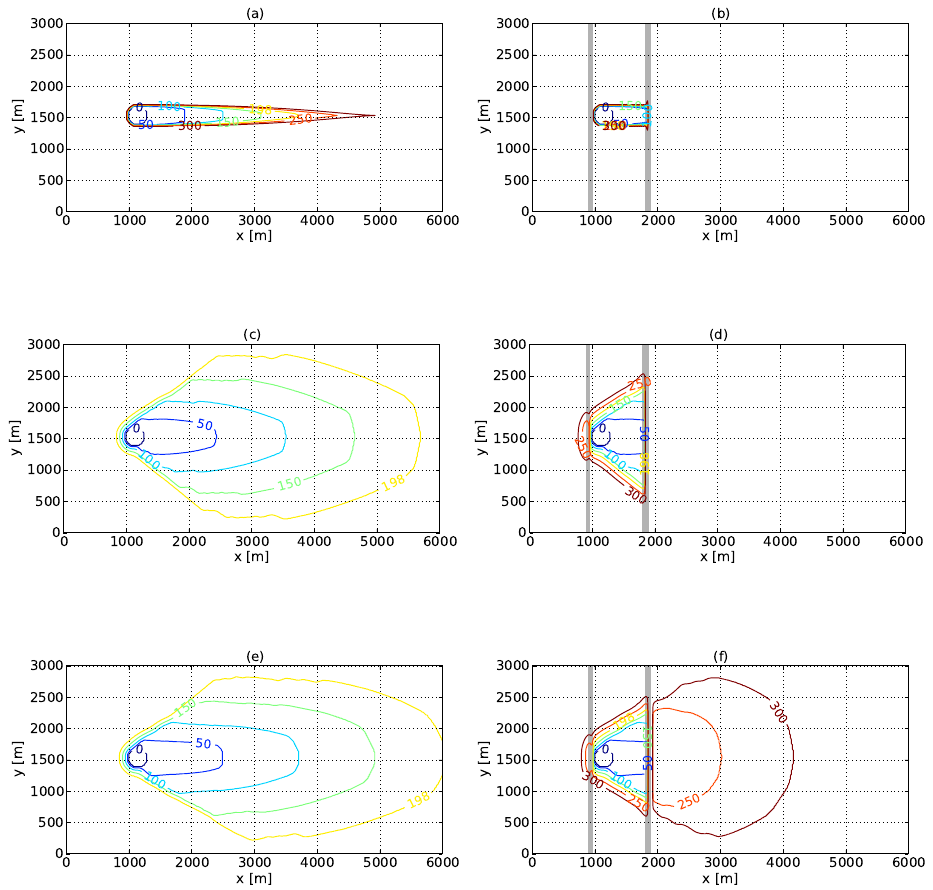
Figure 3. The same as in Fig. 1, but when the mean wind velocity and the fire intensity are U t =17.88ms − 1 and I =10000kWm − 1 (case C ). Fig. 3. The same as in Fig. 1 but when the mean wind velocity and the fire intensity are U t = 17 . 88ms − 1 and I = 10000 kW m − 1 (case C ). (without and with fire breaks), the results obtained by adopt- Figs. 1, 2, 3 and 4, show that the differences between cases are the consequences of the air pre-heating action due to the heat transfer mechanism enhanced by turbulence, and of the rapid ignition connected to embers landing in the yet-to-burn region ahead of the fireline